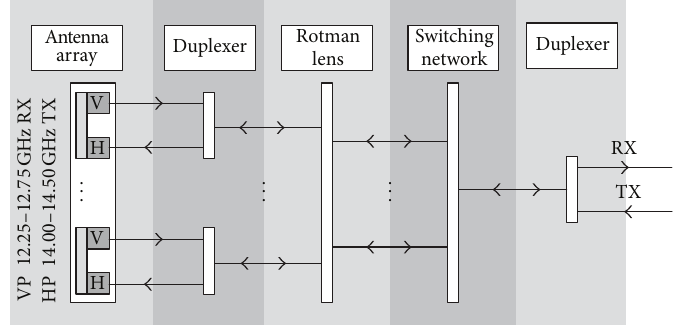
Figure 13: Schematic overview of a Ku-band transmit-receive array.